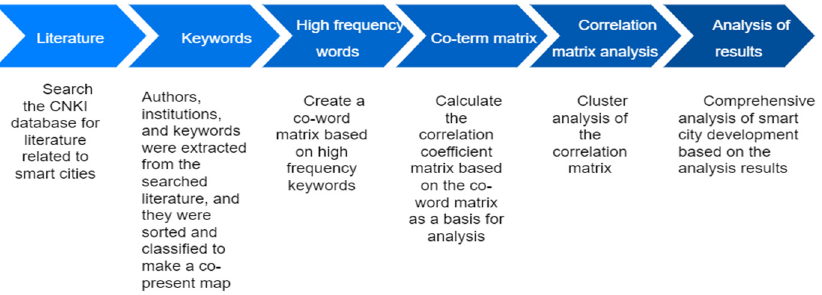
Figure 1. Research technology roadmap.